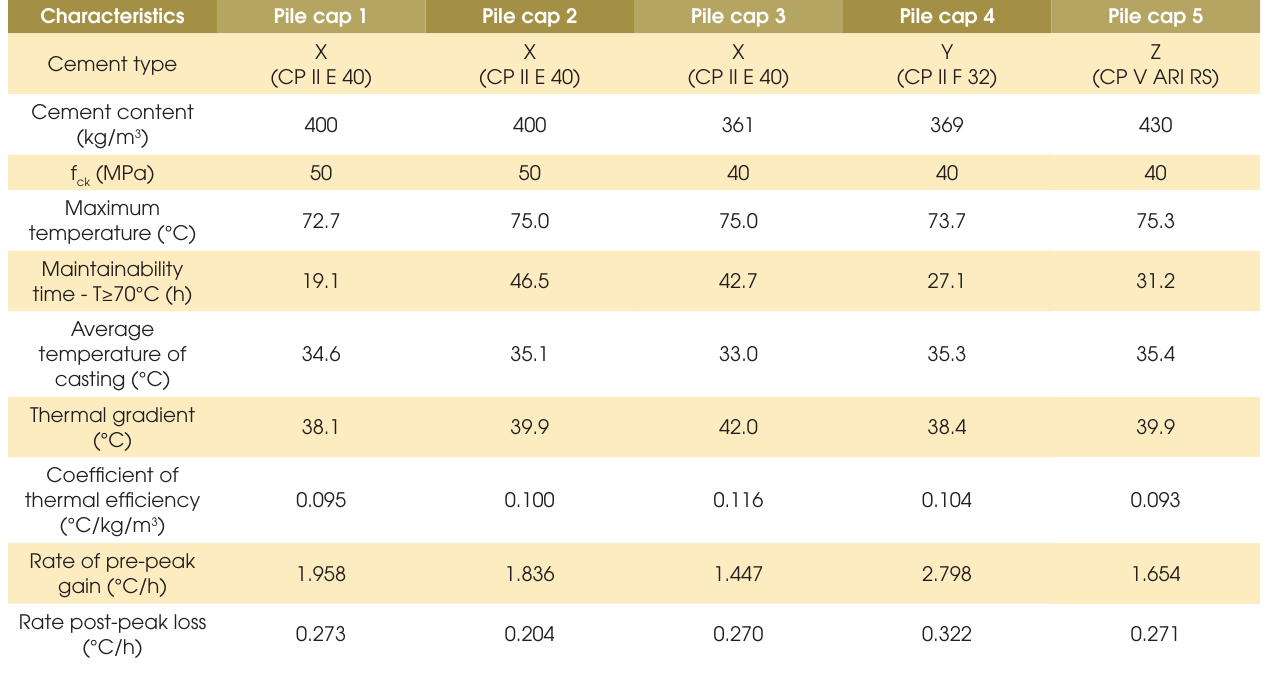
Table 6 – Comparative summary of characteristics and thermal properties of the monitored concretes